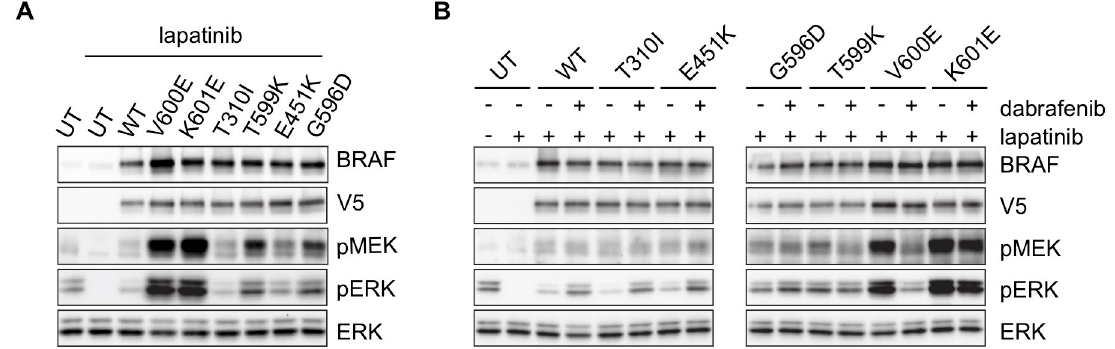
Fig 2. ERK activating ability and sensitivity to dabrafenib of BRAF V600E, K601E, and four BRAF mutations not previously characterized. A-B. V5-tagged BRAF mutants (V600E, K601E, T310I, T599K, E451K and G596D) were expressed in SkBr3 cells overnight and treated with lapatinib (1uM for 1 hour) (A), and then followed by treatment with DMSO or dabrafenib (200nM) for 1 hour (B). UT = untransfected. Expression and/or phosphorylation of the indicated proteins were assessed by immunoblot.